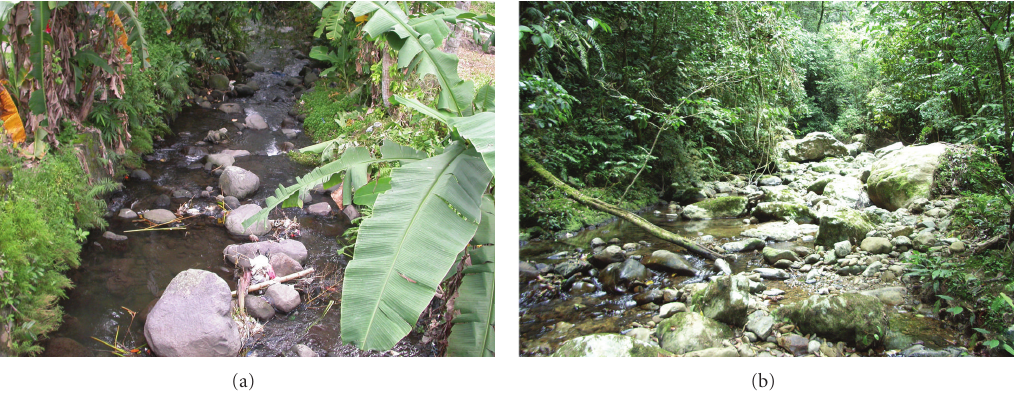
Figure 11: Habitats of Hydrocyphon spp. (a) Ngaglik, Yogyakarta (type locality of H . jogjaensis sp.n., 28. II. 2010, photo by H. Yoshitomi); (b) Kinabalu Park, Sabah (type locality of H . takizawai sp.n., 4. V. 2010, photo by H.